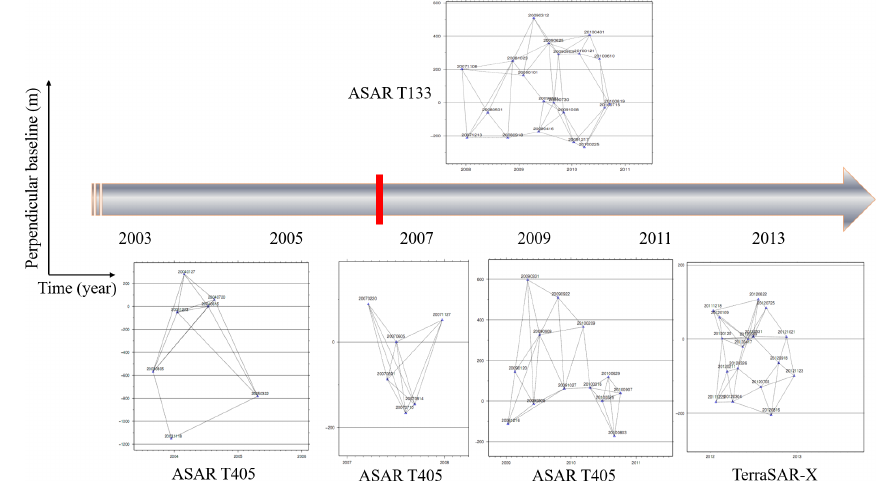
Figure 3. Temporal and perpendicular baselines for the interferograms used in this study. Different graphs represent the baselines of different data generated during different time periods. In each figure, the horizontal axis represents the time (year) and the vertical axis represents the perpendicular baseline